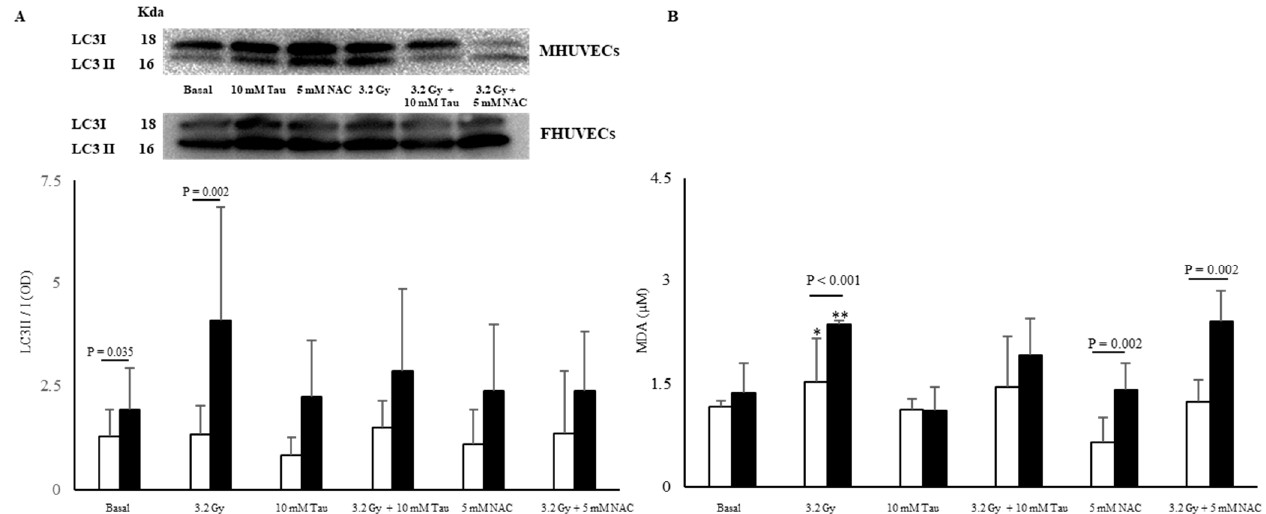
Figure 3. LC3II/I ratio ( A ) and MDA levels ( B ) in non-irradiated and irradiated MHUVECs (white bars) and FHUVECs (black bars) before and after pre-treatments. Data are reported as the means ± SD of at least 3 independent experiments. * p = 0.032 basal vs. 3.2 Gy in MHUVECs; ** p < 0.001 basal vs. 3.2 Gy in FHUVECs.